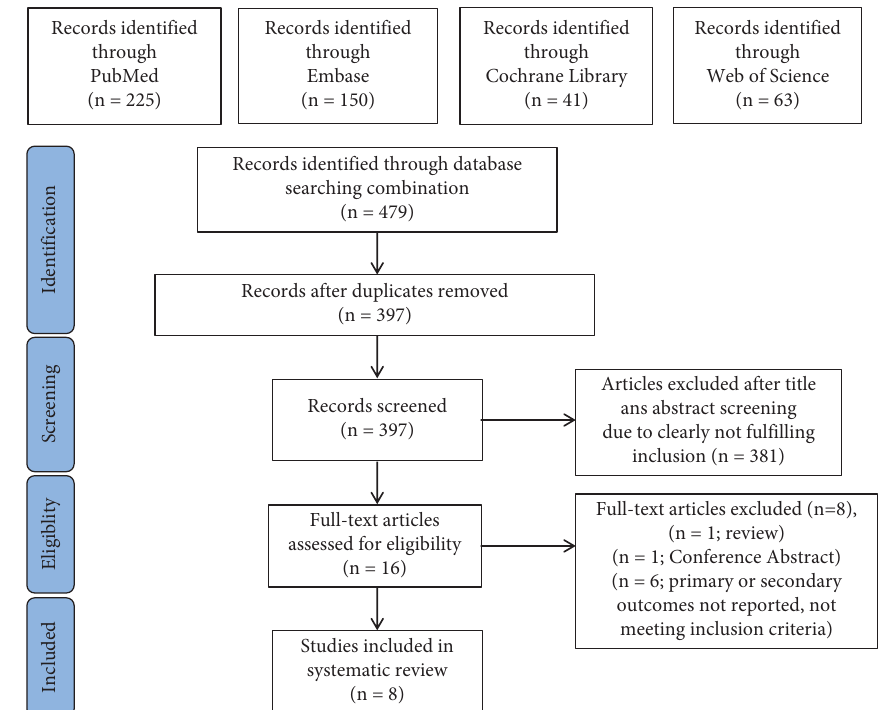
Figure 1: Flow diagram of the literature search and the article evaluation